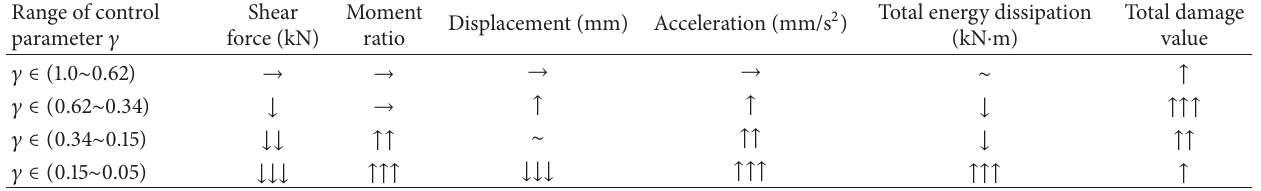
Table 5: Analytical table of the influence of varying energy degradation-based parameter 𝛽 on structural responses and damage. Range of control Shear force parameter 𝛽 (kN) ratio 𝛽 ∈ ( 0.01 ∼ 0.13